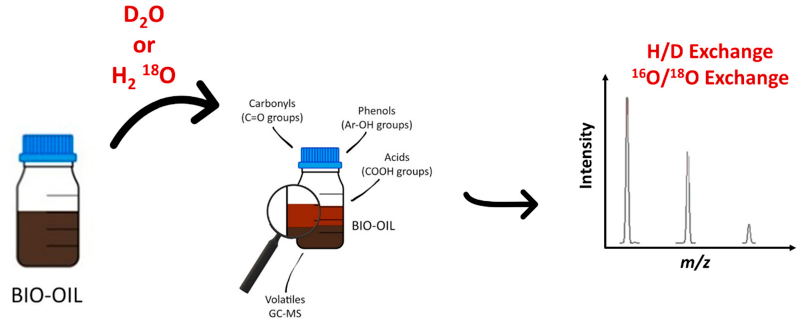
Figure 9. The outline for the isotope labelling.